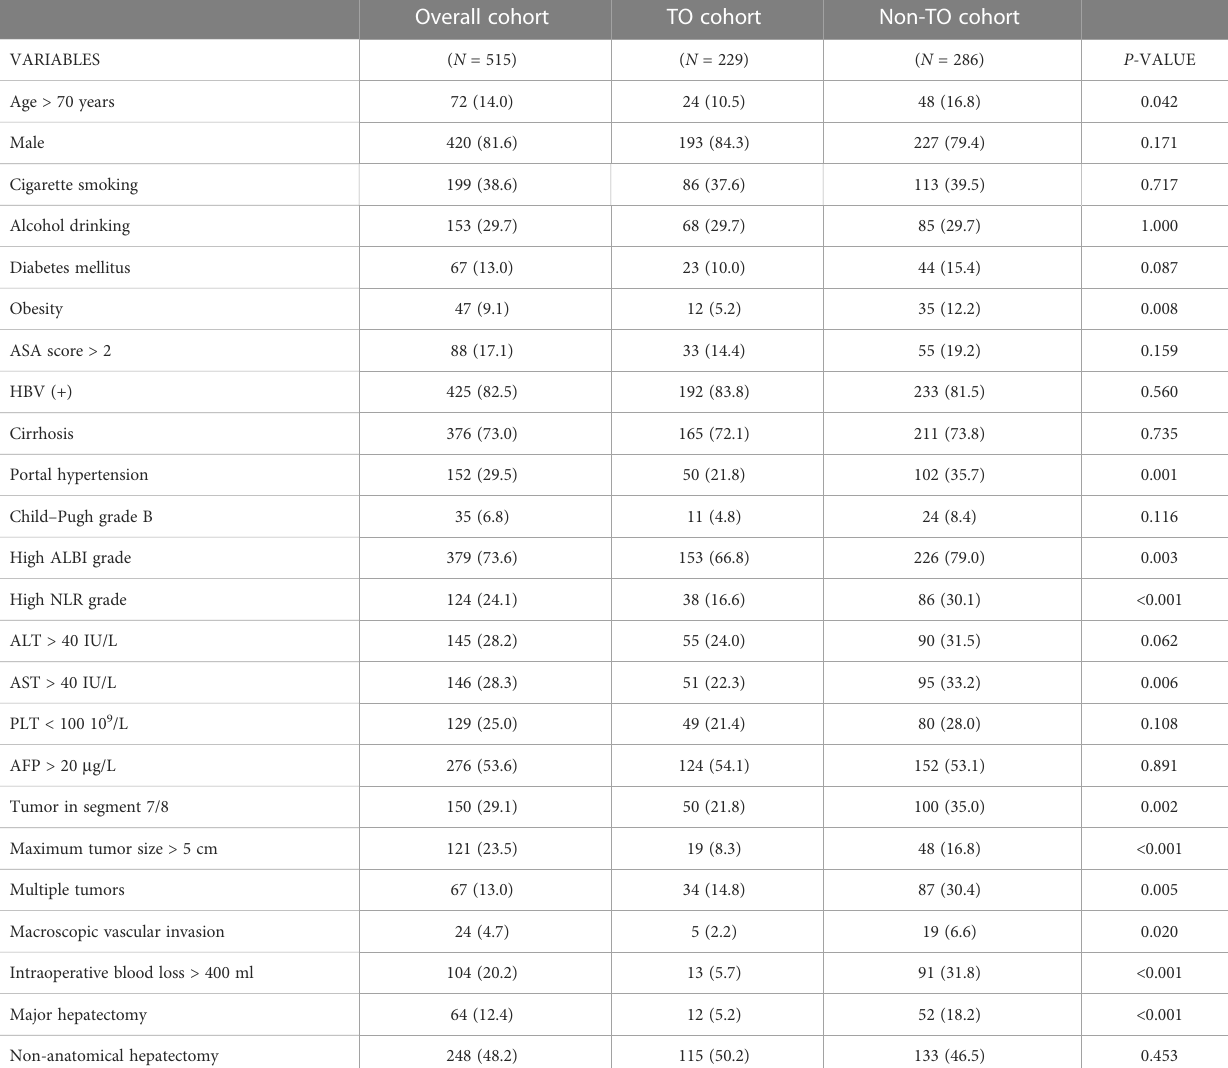
TABLE 1 Comparisons of clinical characteristics among the two groups according to textbook outcomes. Overall